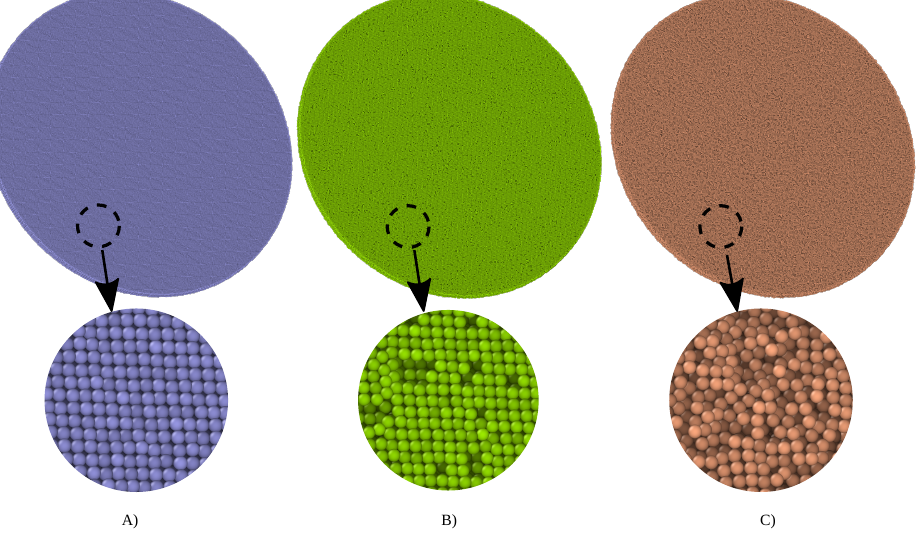
Figure 2. Voids in the workpiece: ( A ) No voids, ( B ) 5% material flaw, and ( C ) 15% material flaw in the